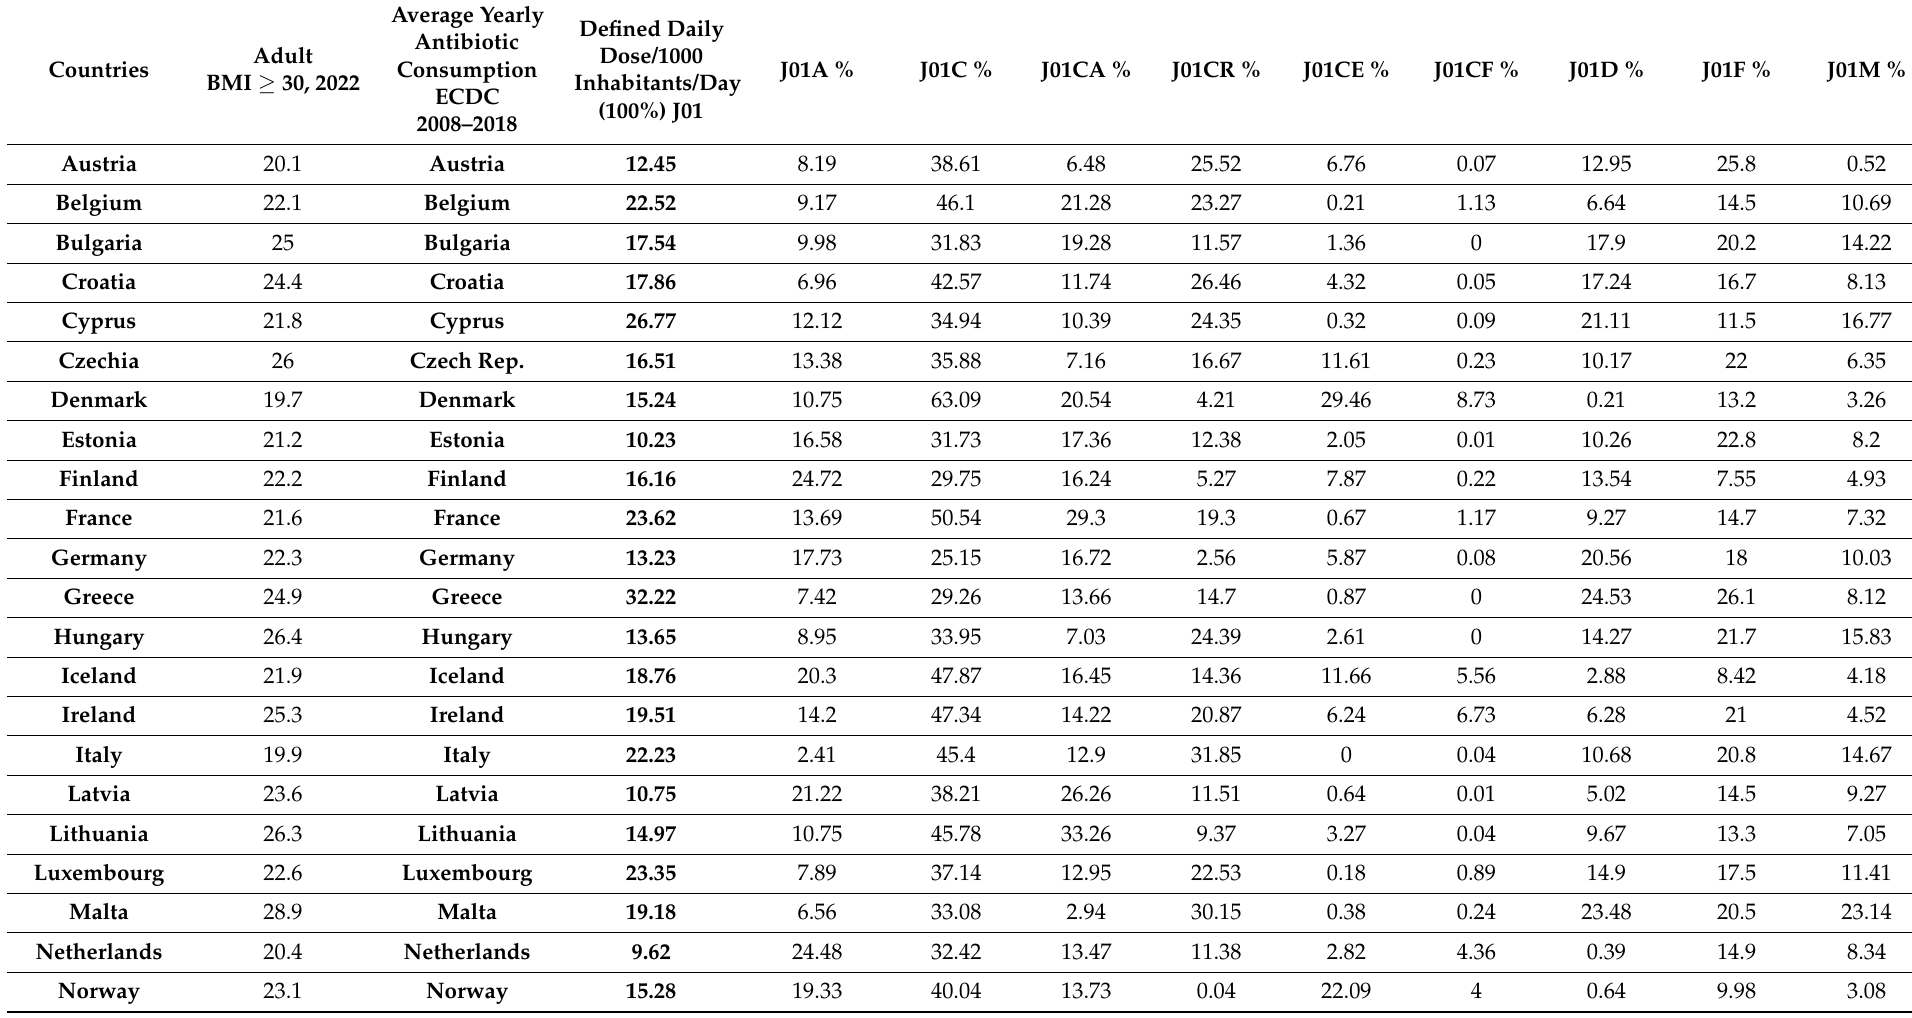
Table 2. Prevalence of adult obesity compared to the antibiotic consumption data, and the results of the